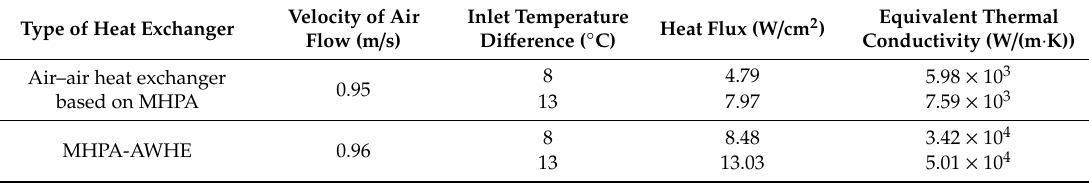
Table 4. Performance of two kinds of heat exchangers based on MHPA.